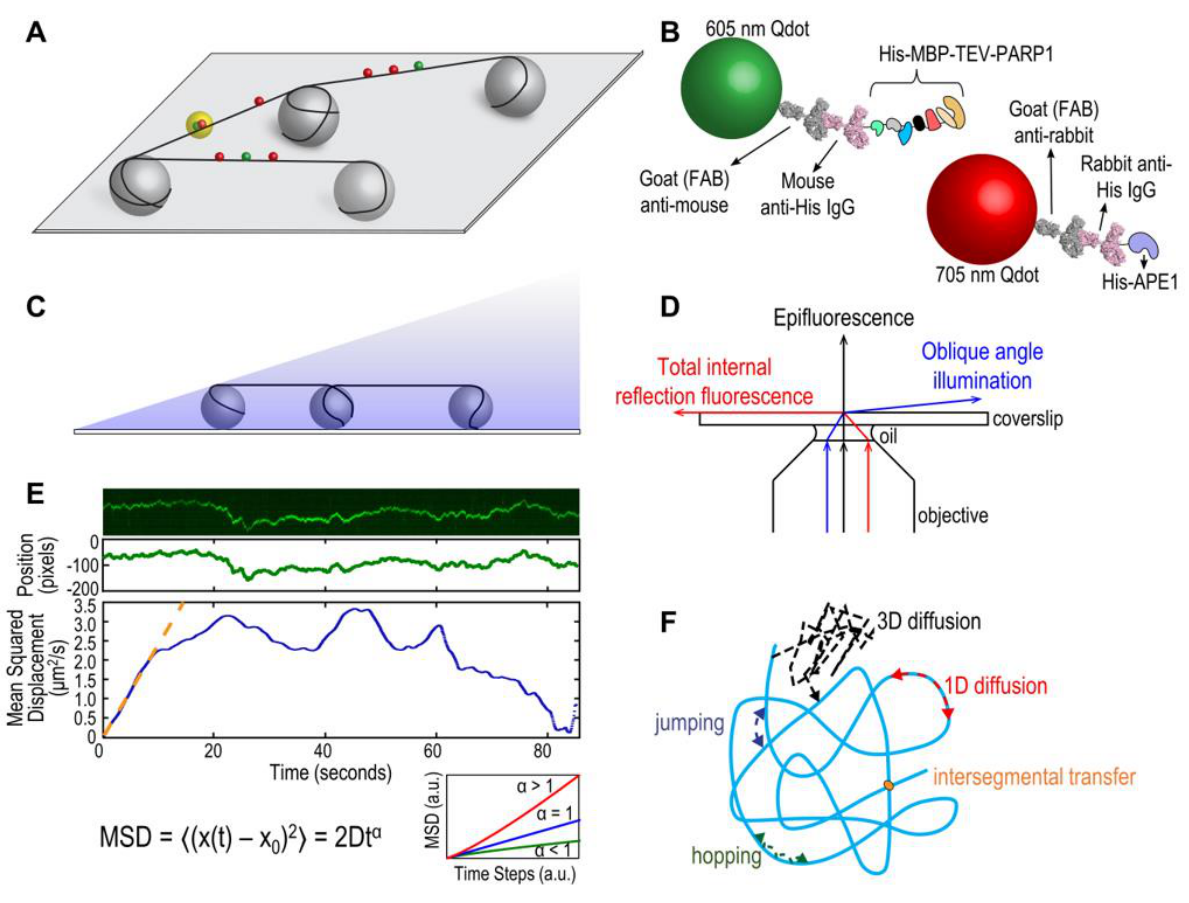
FIGURE 1: (A) Schematic of DNA tightrope setup. Long DNA molecules are suspended between 5 μm poly -L-lysine-coated silica beads on a glass coverslip. Qdot-labeled proteins bound to DNA shown in red and green (see B); colocalized particles highlighted in yellow. Adapted with permission from [13]. (B) Two orthogonal Qdot-protein labeling strategies. Top: A 605 nm Qdot (green) with conjugated anti-mouse secondary antibody (grey) bound to a mouse anti-His primary antibody (pink), bound to a His-tagged protein. Bottom: A 705 nm Qdot (red) with conjugated anti-rabbit secondary antibody (grey) bound to a rabbit anti-His primary antibody (pink), bound to a His-tagged protein. Adapted with permission from [13]. (C) DNA tightropes in a flow cell with oblique angle illumination. Adapted with permission from [8]. (D) Ray diagram showing incident laser light paths for epifluorescence (black), TIRF at the critical angle (red), and oblique angle illumi- nation (blue). Adapted with permission from [8]. (E) Top: Sample kymograph of a Qdot-labeled protein displaying random linear diffusion on a DNA tightrope. Y axis, position; X axis, time. Middle: 1D Gaussian fittings of the light intensity profile at each time point of the above kymograph shown as position in pixels vs. time. 1 pixel = 46 nm. Bottom: Mean squared displacement (MSD) vs. time. The initial linear portion of the MSD plot is fit to the equation MSD = 2Dt α (orange line). Inset: Sub- types of 1D diffusion defined by α values. Super - diffusion (red), random diffusion (blue), sub-diffusion (green). Adapted with permission from [11]. (F) Modes of protein-DNA interaction. Search strategies typically involve some combination of: 3D diffusion in solution (black), 1D linear diffusion (red), jumping (blue) or hop- ping (green) between DNA segments, and intersegmental transfer (orange). Adapted with permission from